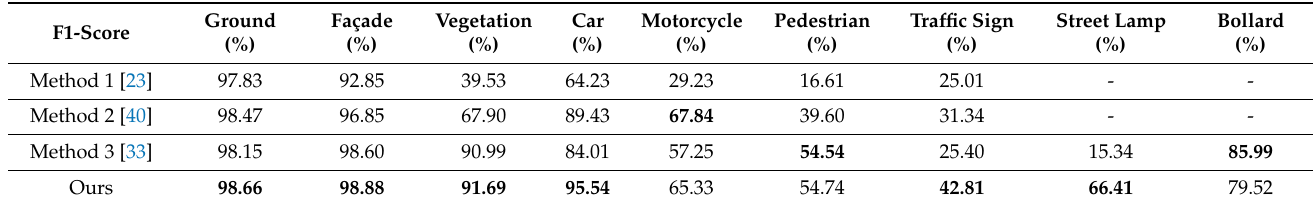
Table 7. F1-score of different methods in the Paris-rue-Cassette dataset.